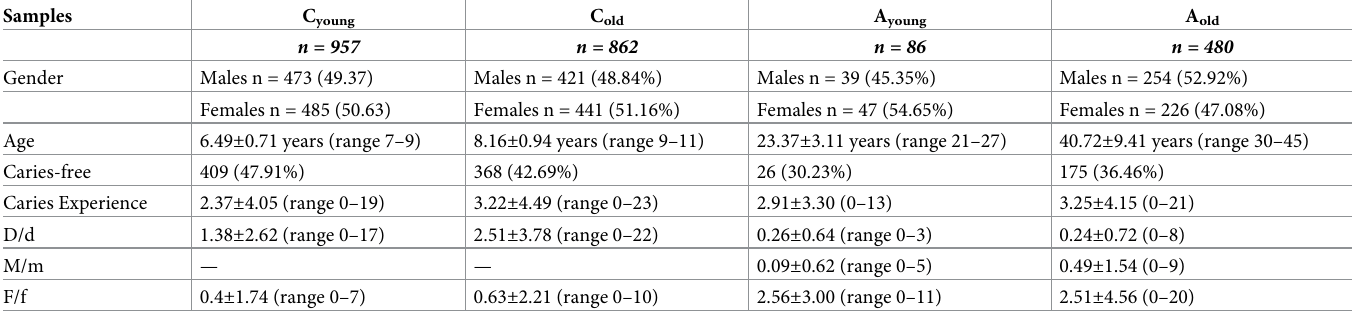
Table 2. Description of the sample.